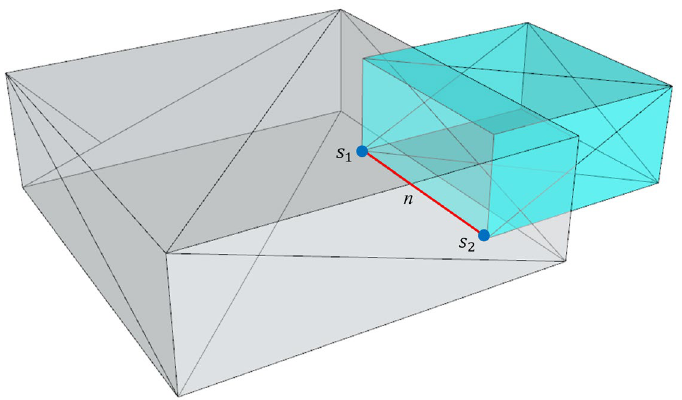
is located is not closed ( is the boundary 𝑛𝑛 𝑛𝑛